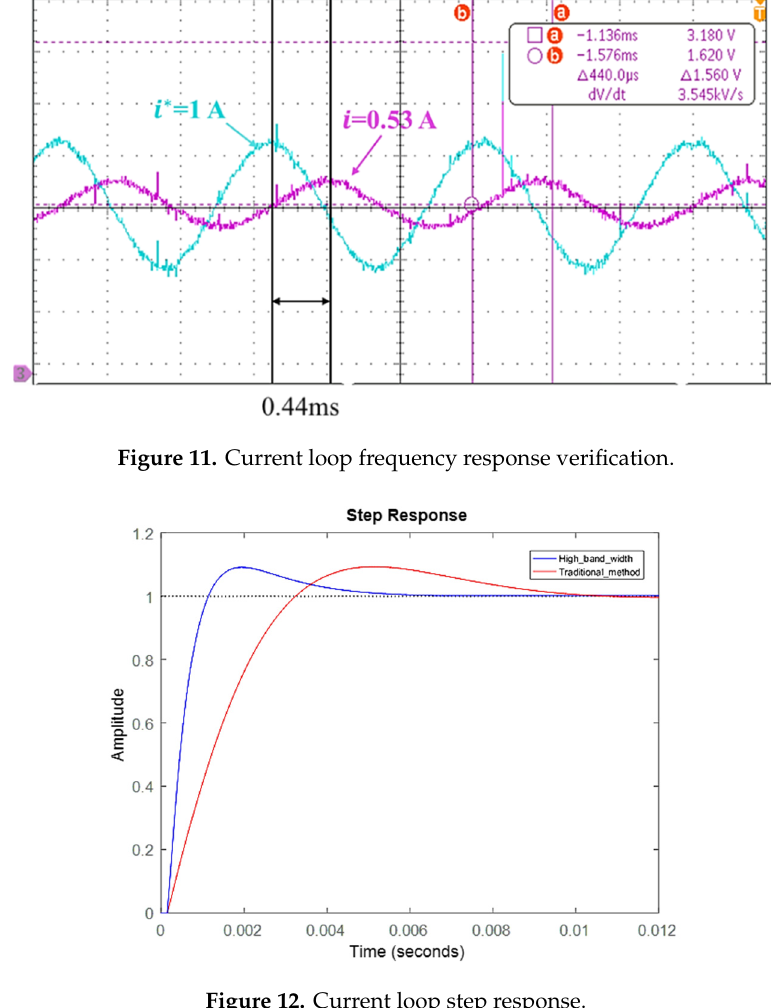
Figure 12. Current loop step response. Table 3. Current loop step response parameter.